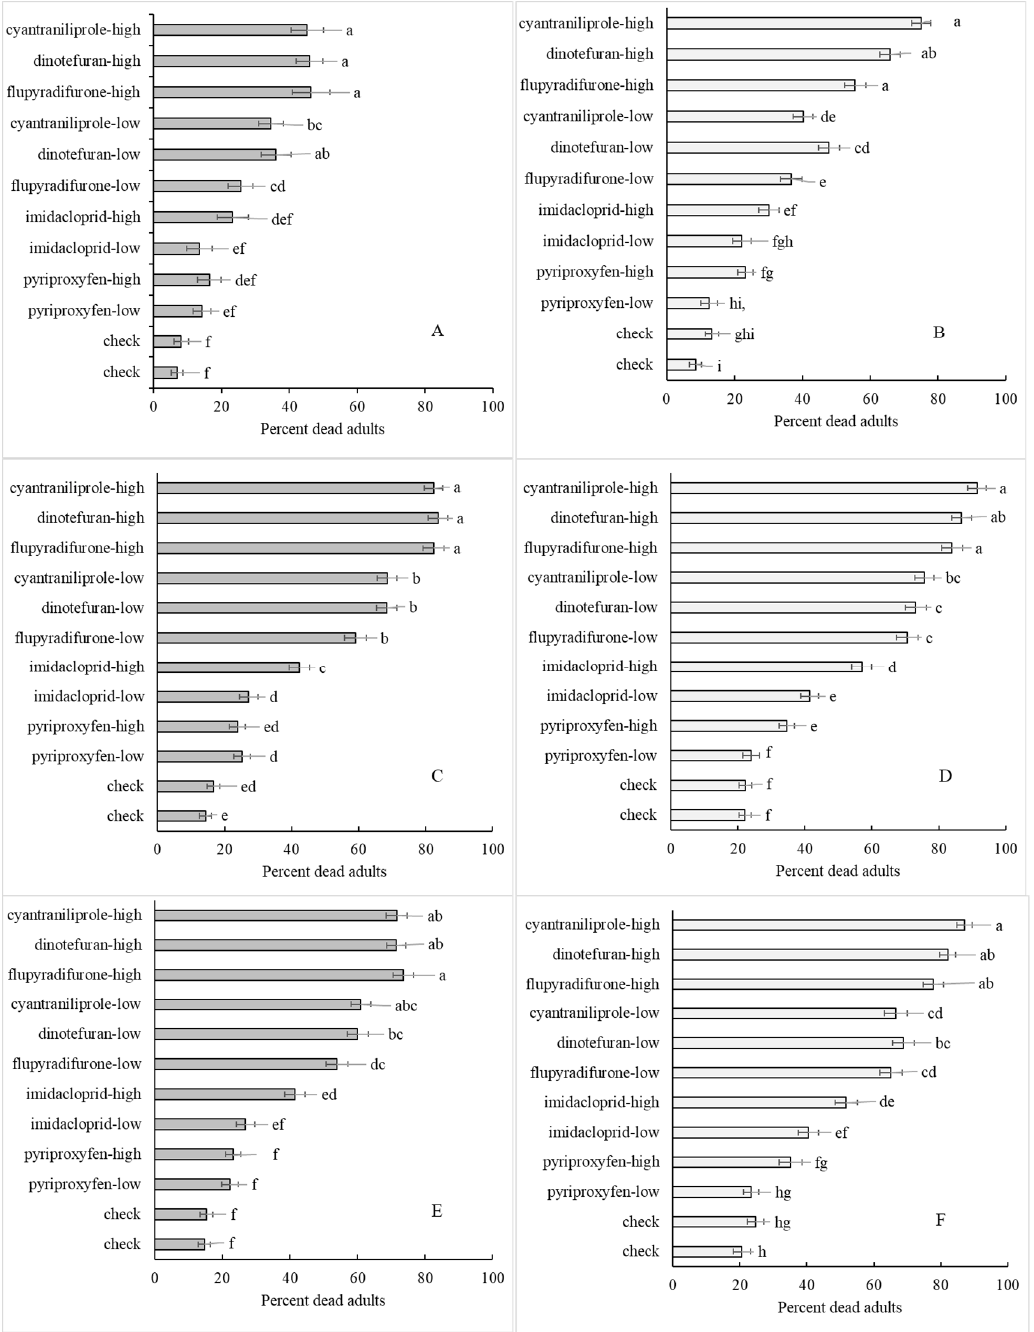
Figure 4. Percent adult mortality of the Florida ( A , C , E ) and Georgia ( B , D , F ) whitefly populations across insecticide treatments at 24 h ( A , B ), 48 h ( C , D ) and overall ( E , F ) (means with the same lower case letter not significantly different, LSD 24 and 48 h, Tukey’s test overall, p < 0.05).